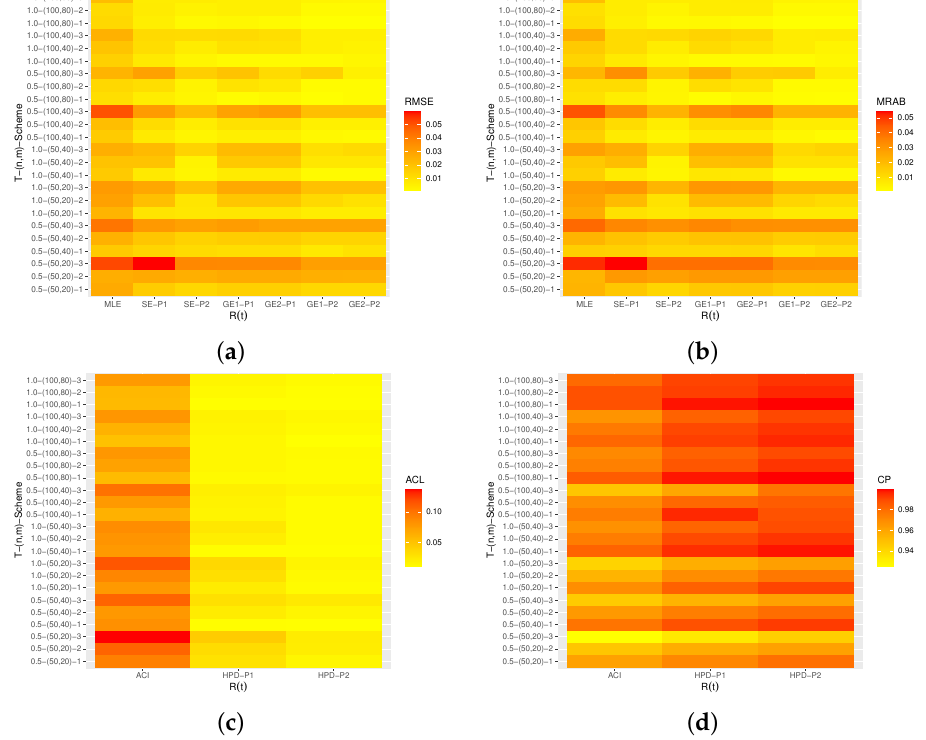
Figure 3. Heatmap plots for the estimation results of R ( t ) . ( a ) RMSE. ( b ) MRAB. ( c ) ACL. ( d )